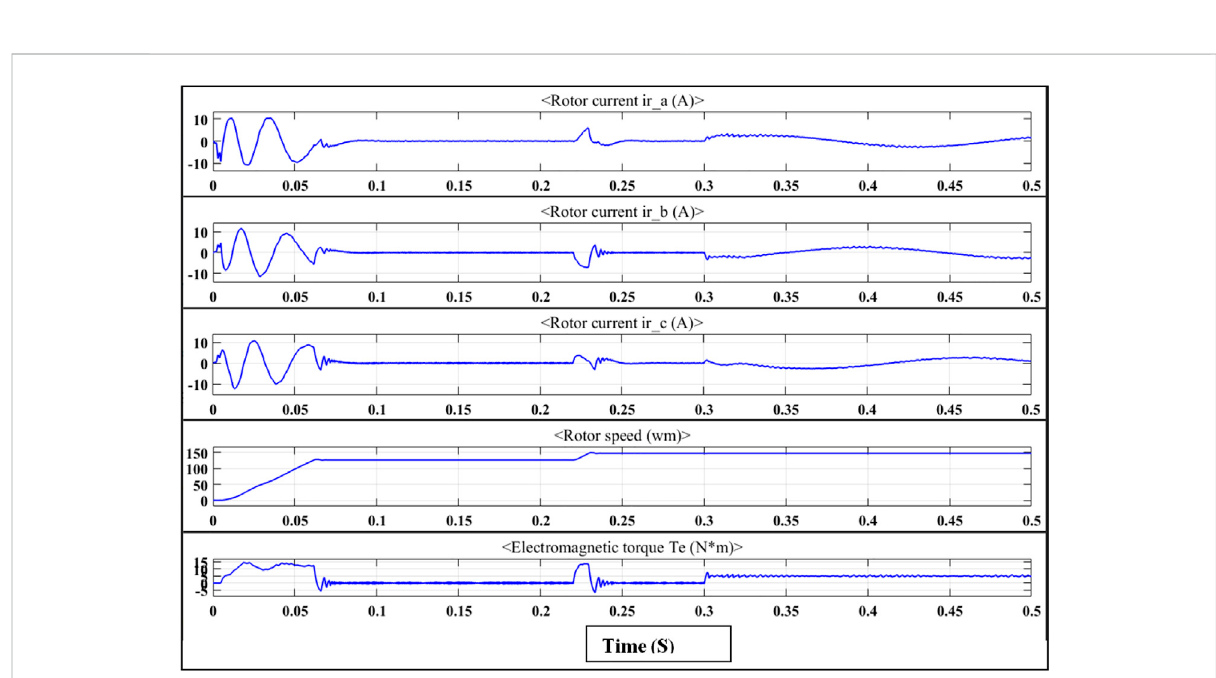
FIGURE 15 Current, speed, and torque of induction motor